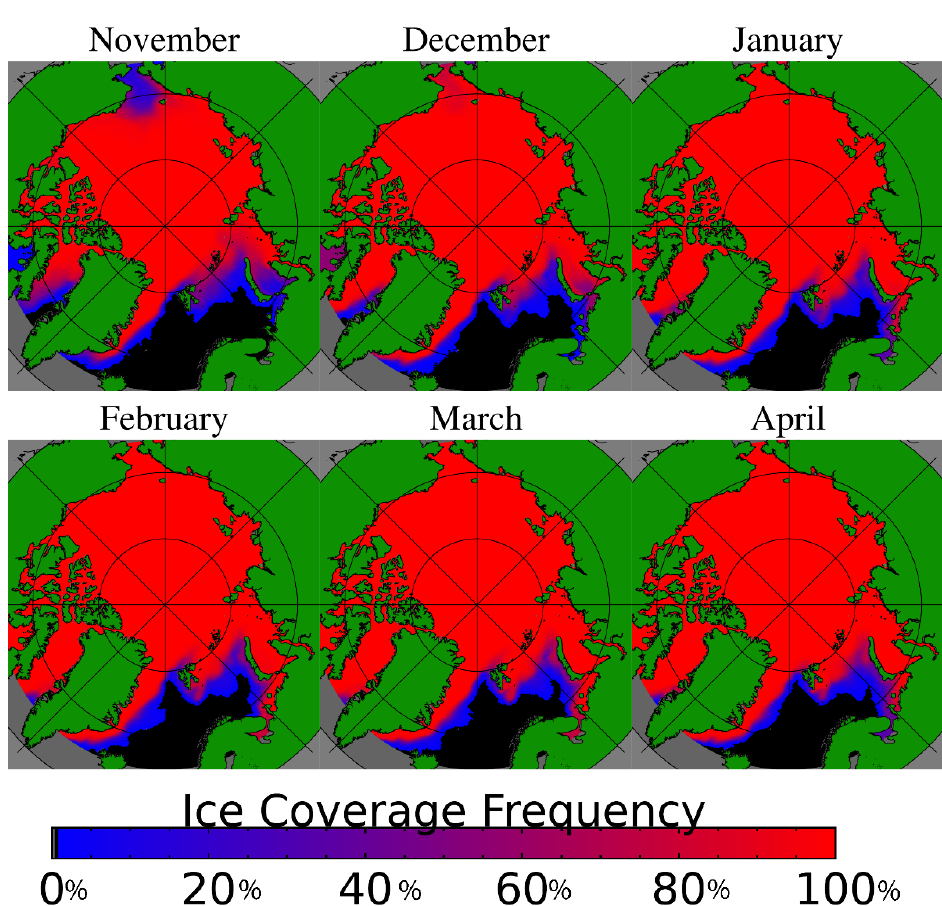
Figure 6. Monthly ice coverage [27] for the winter months of November 2002 through April 2022.